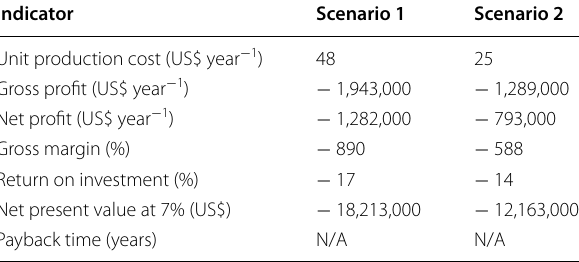
Table 5 Indicators for process profitability for Scenario 1 and